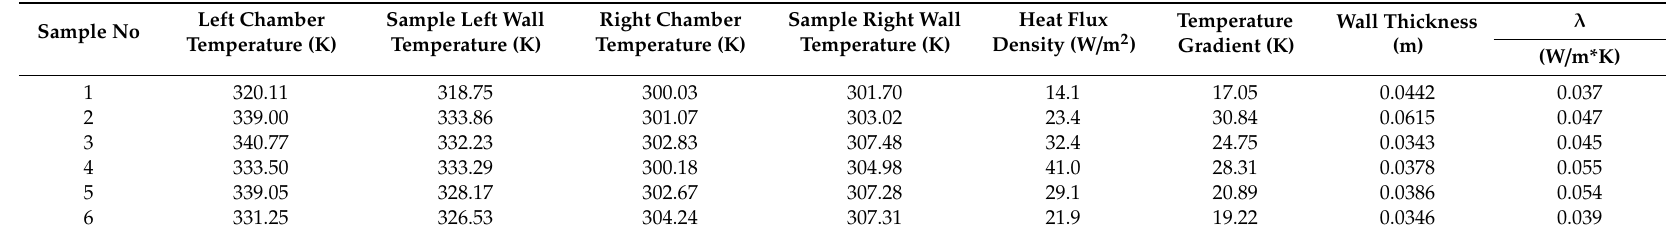
Table 4. Heat transfer coe ffi cient ” λ ”